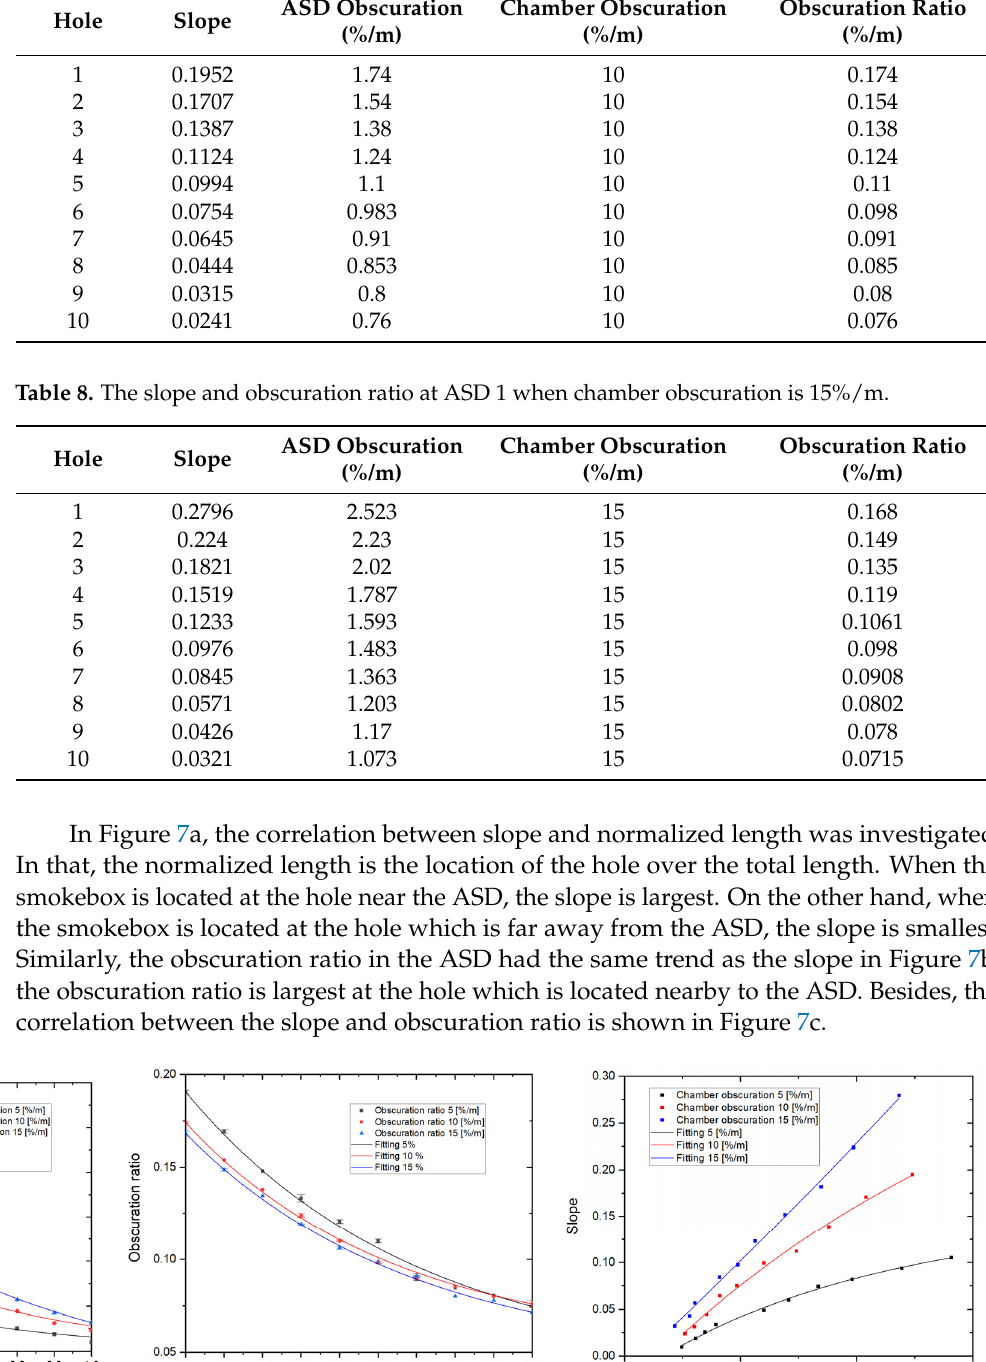
Table 7. The slope and obscuration ratio at ASD 1 when chamber obscuration is 10%/m. Hole